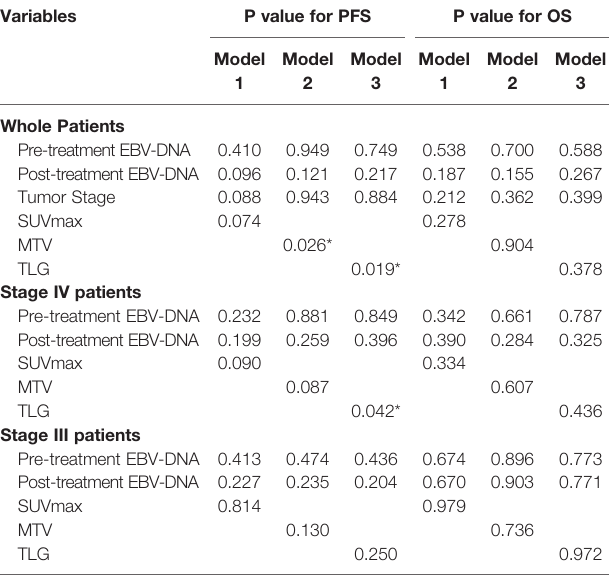
TABLE 4 | Multivariate analysis for PFS and OS in patients with pulmonary LELC.